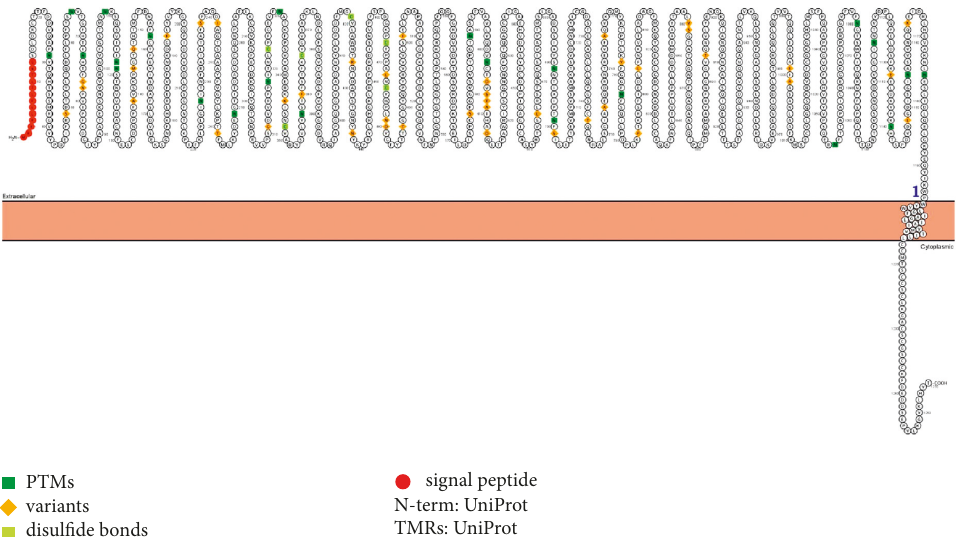
Figure 9: Identification of signal peptide in SARS-CoV-2-SG by PROTTER.